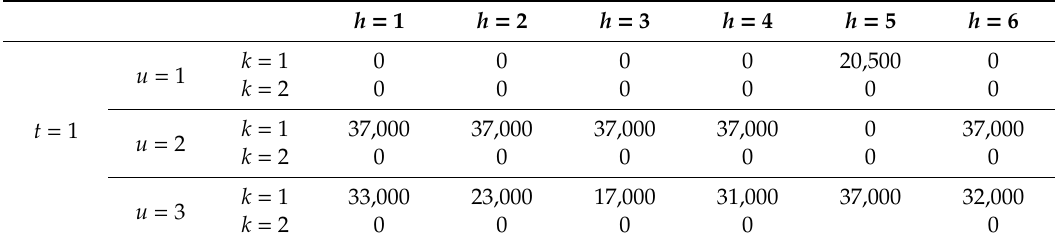
Table 24. Quantity of surgical instruments supplied by distributor d = 2 to all hospitals in period t =